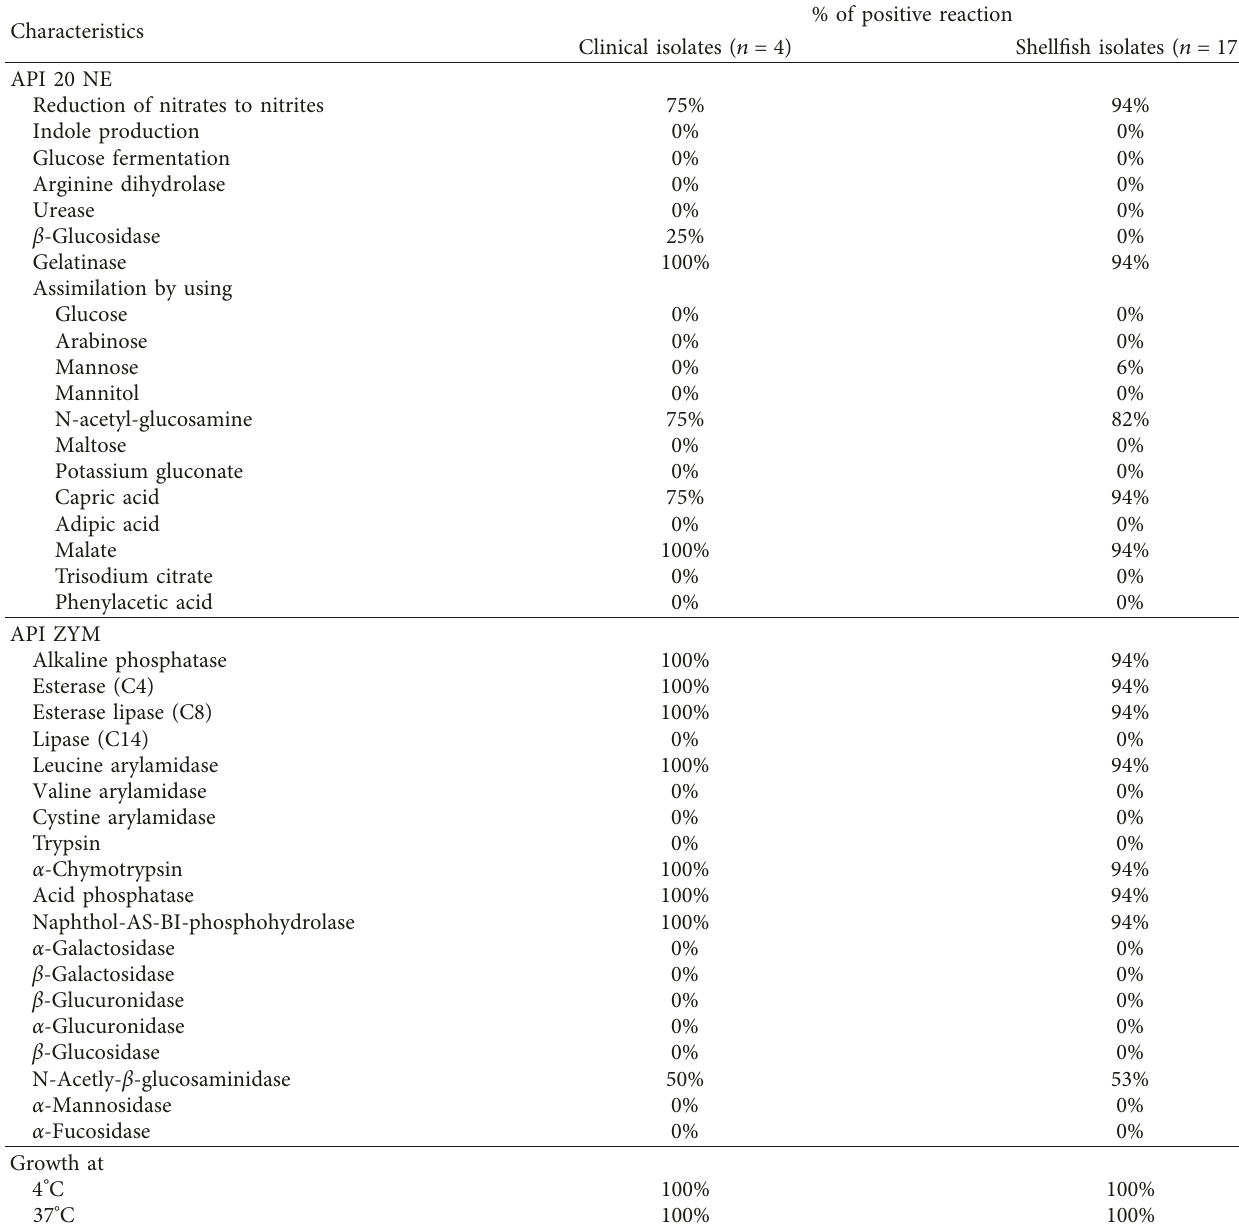
Table 3: Characterization of Shewanella haliotis